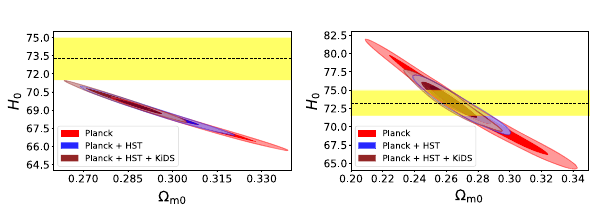
Fig. 2 Parametric space (at 68% and 95% CL) in the plane (cid:11) m0 − S 8 for the (cid:3) CDM (left panel) and IVCDM model (right panel) from four data sets. In the left panel, we see that the (cid:11) m0 − S 8 region given by the Planck data within the (cid:3) CDM cosmology is clearly in disagreement √ (cid:11) / 0 . 30 = 0 . 651 ± 0 . 058, predicted by with the region S 8 ≡ σ 8 m0 KiDS data [7] (red band). In the right panel for the IVCDM model, we observe that there is no tension on S 8 within 68% CL